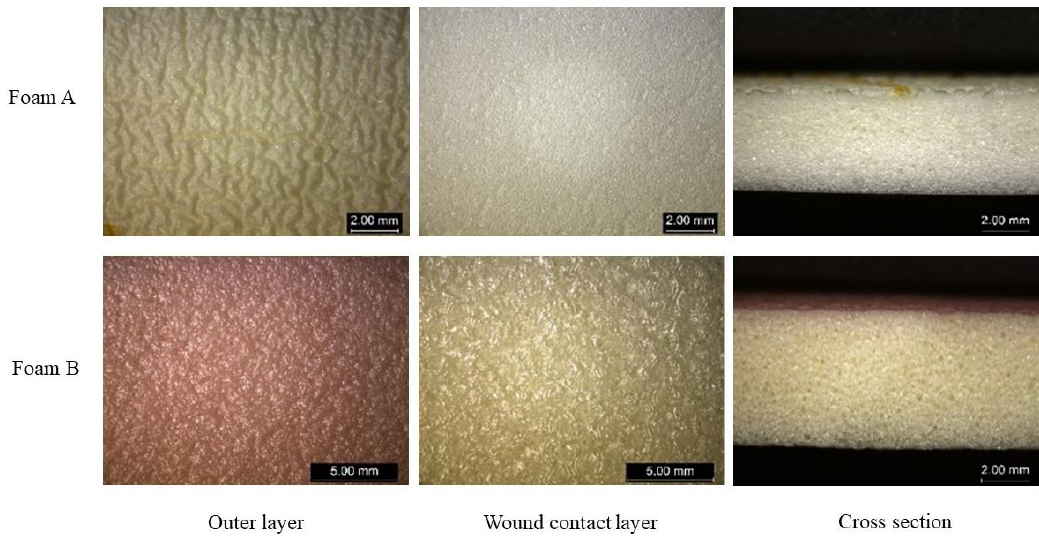
Figure 4. Photographs of the foam dressings from market.